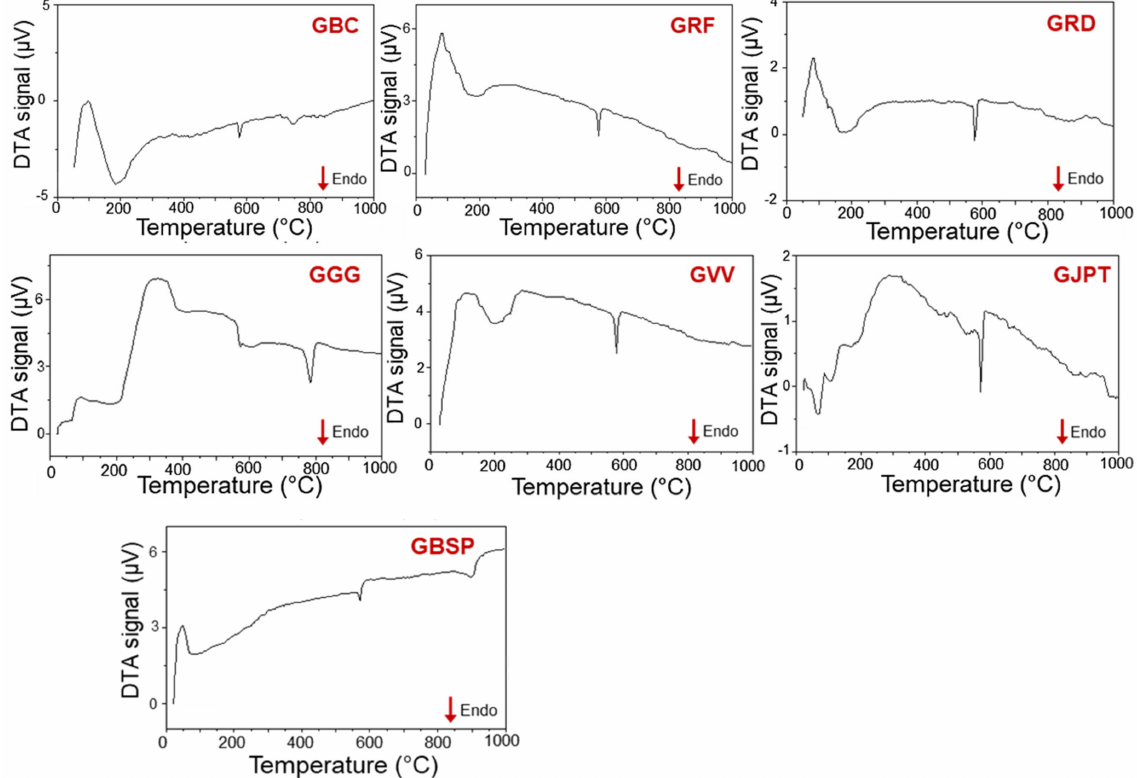
Figure 4. DTA curves obtained from granites (GBC, GRF, GRD, GGG, GVV, GJPT, and GBSP)